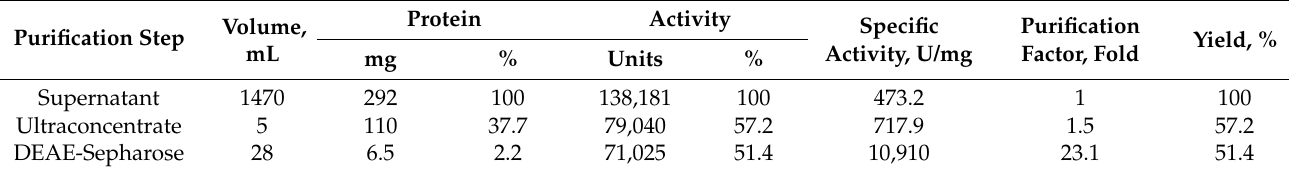
Table 1. Purification profile of the lipase from Brevibacillus thermoruber strain